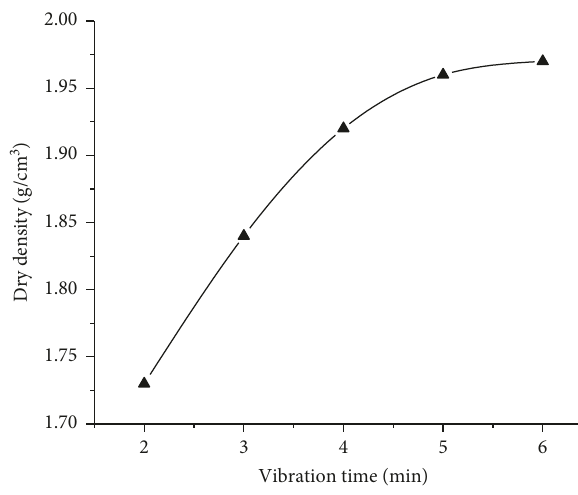
Figure 5: Relationship between dry density and vibration time. Table 3: Minimum strength and compaction degree of highway subgrade